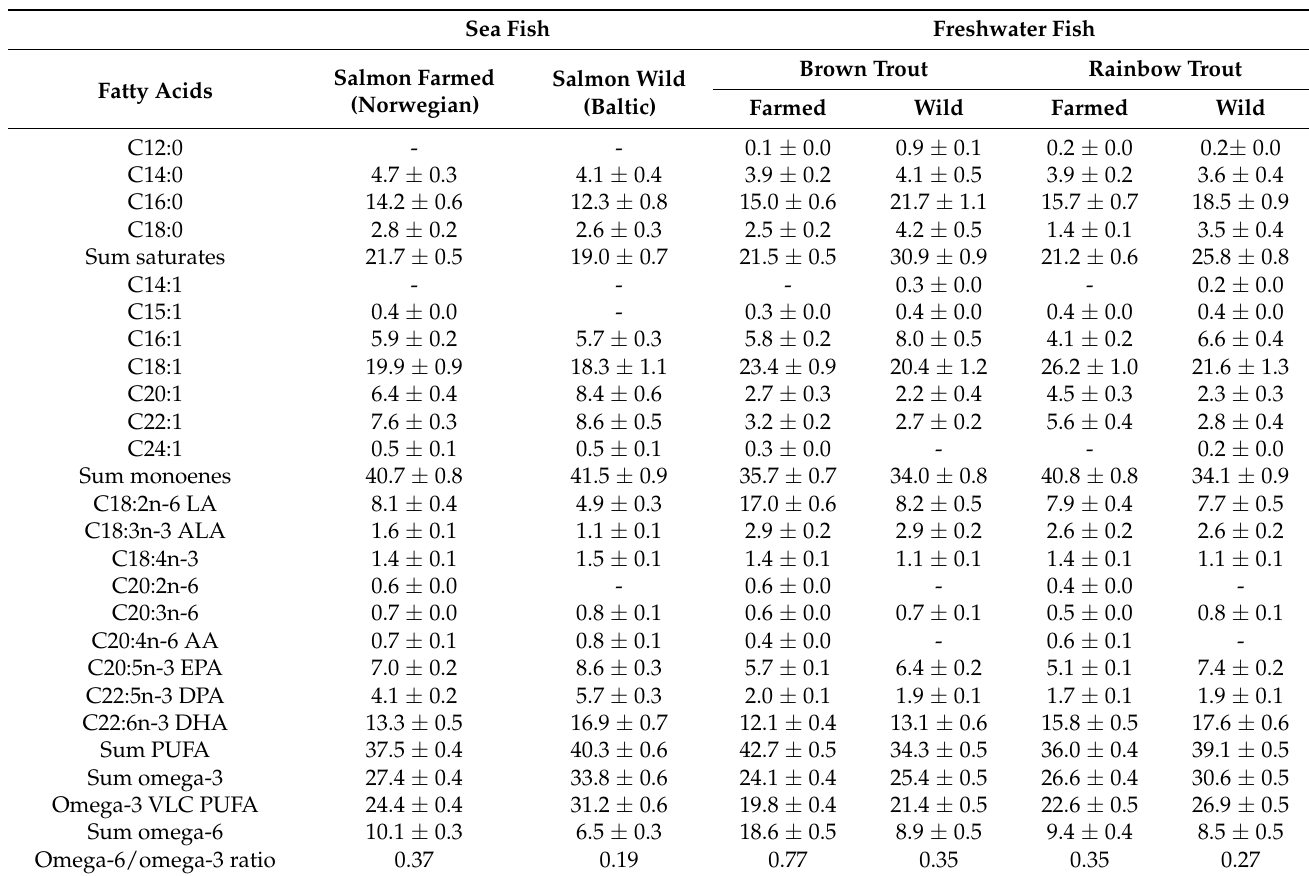
Table 2. Fatty acid composition of fat extracted form fillets of salmonids; % of total fatty acids. Sea Fish Freshwater Fish